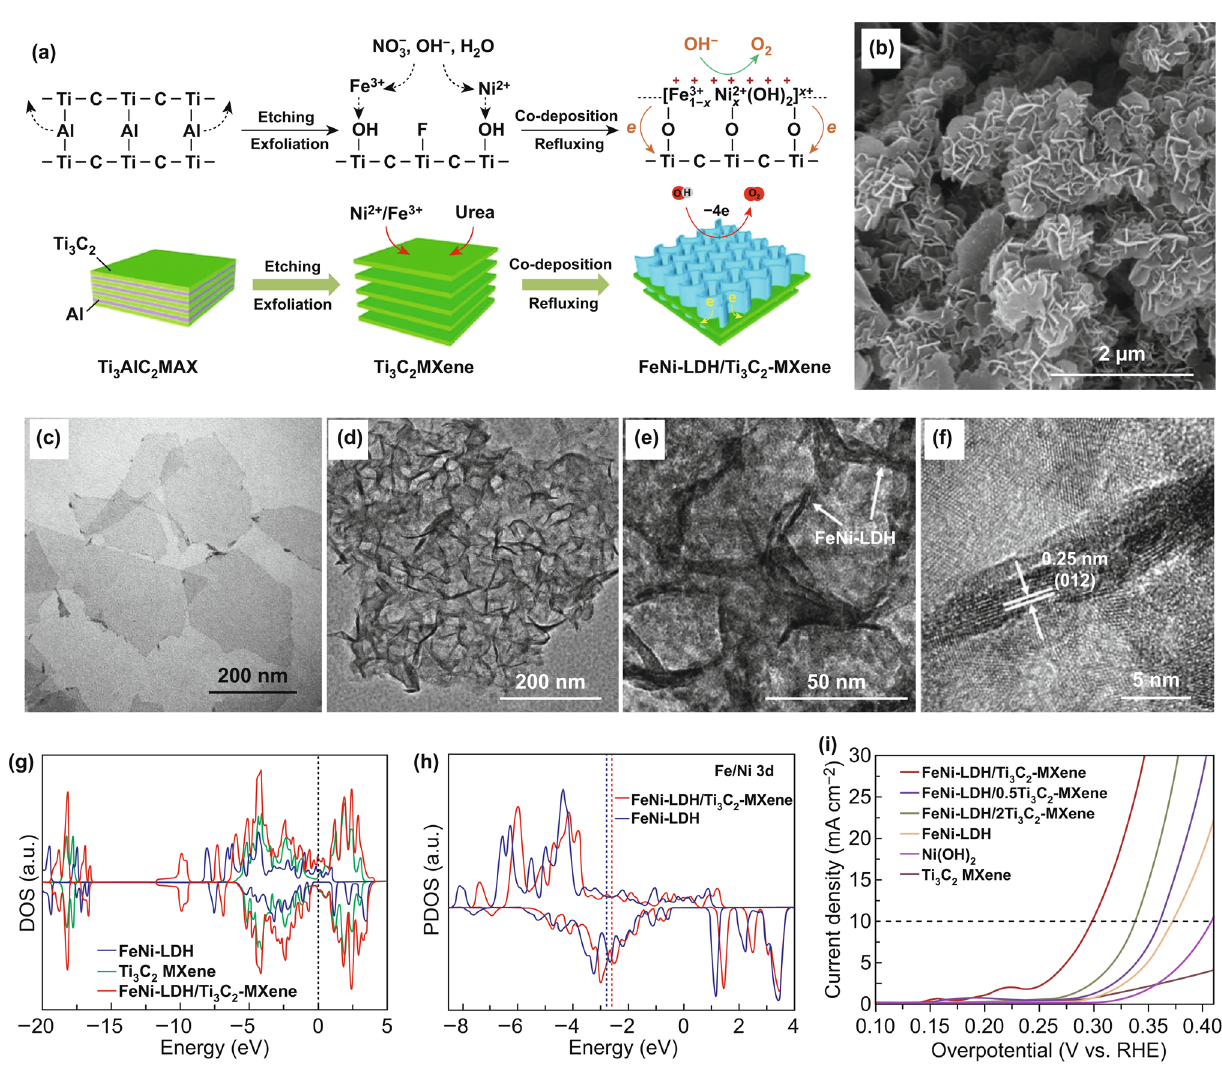
Fig. 13 a Schematic diagram of the preparation of FeNi‑LDH/Ti 3 C 2 MXene hybrids. b SEM image, c TEM image, d – f HRTEM images of FeNi‑LDH/Ti 3 C 2 MXene. g density of states (DOS), h projected DOS (PDOS) of different samples. i LSV curves of as‑prepared catalysts at 10 mV s −1 in 1 M KOH. Reproduced with permission of Ref. [130]. Copyright 2017 Elsevier